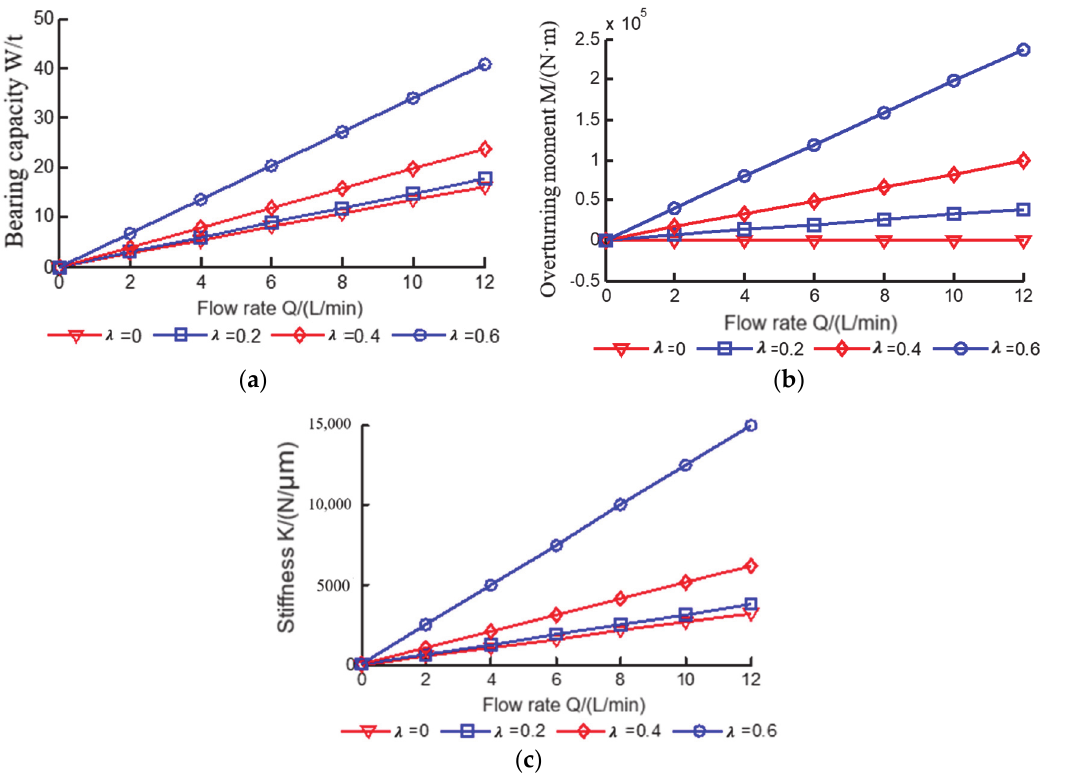
Figure 12. Influence of flow rate on bearing characteristics. ( a ) Influence on oil film bearing capacity; ( b ) Influence on oil film overturning moment; ( c ) Influence of inclined displacement rate on oil film stiffness.